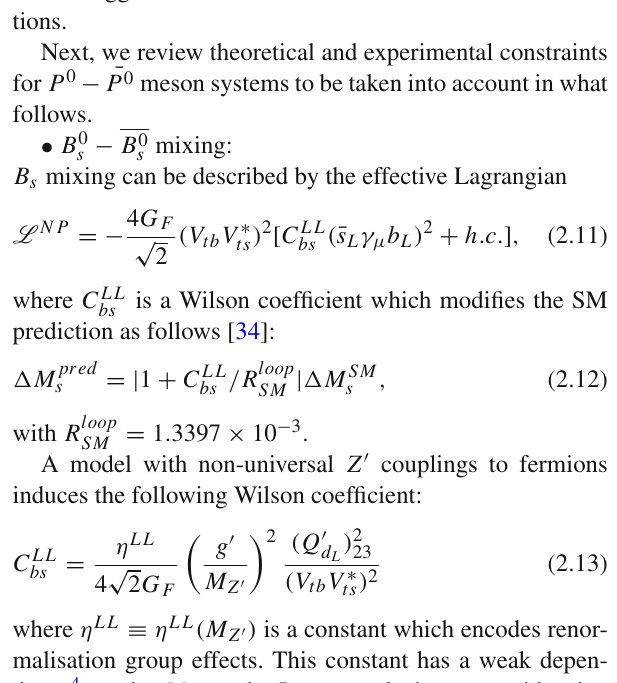
Fig. 2 Left figure: Representative box diagram contribute to ( B 0 s − non-universal Z (cid:2) gauge